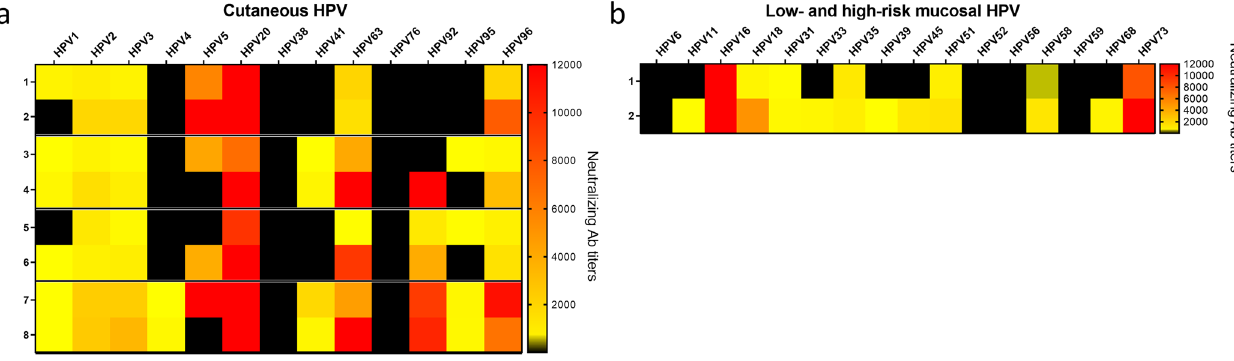
Fig. 2 PfTrx-L2c6mer and PfTrx-L2c9mer polytopes induce a broad immune response in guinea pigs. Heat maps show the neutralizing antibody titers to cutaneous HPV types ( a ) measured by the L1-PBNA in sera from eight guinea pigs immunized with 30 µg of the PfTrx- L2c6mer (rows 1 and 2), PfTrx-L2c9mer (rows 3 and 4), PfTrx-L2c6merOVX313 (rows 5 and 6) and PfTrx-L2c9merOVX313 (rows 7 and 8) antigens. b The immunogenicity of 30 µg of PfTrx-L2c6mer (row 1) and PfTrx-L2c9mer (row 2) against low- and high-risk mucosal HPV types was also assessed by the L1-PBNA. Antibody titers ranging from 50 to 12,000 are color-coded in yellow to red; black color indicates EC50 values <50 (no neutralization).